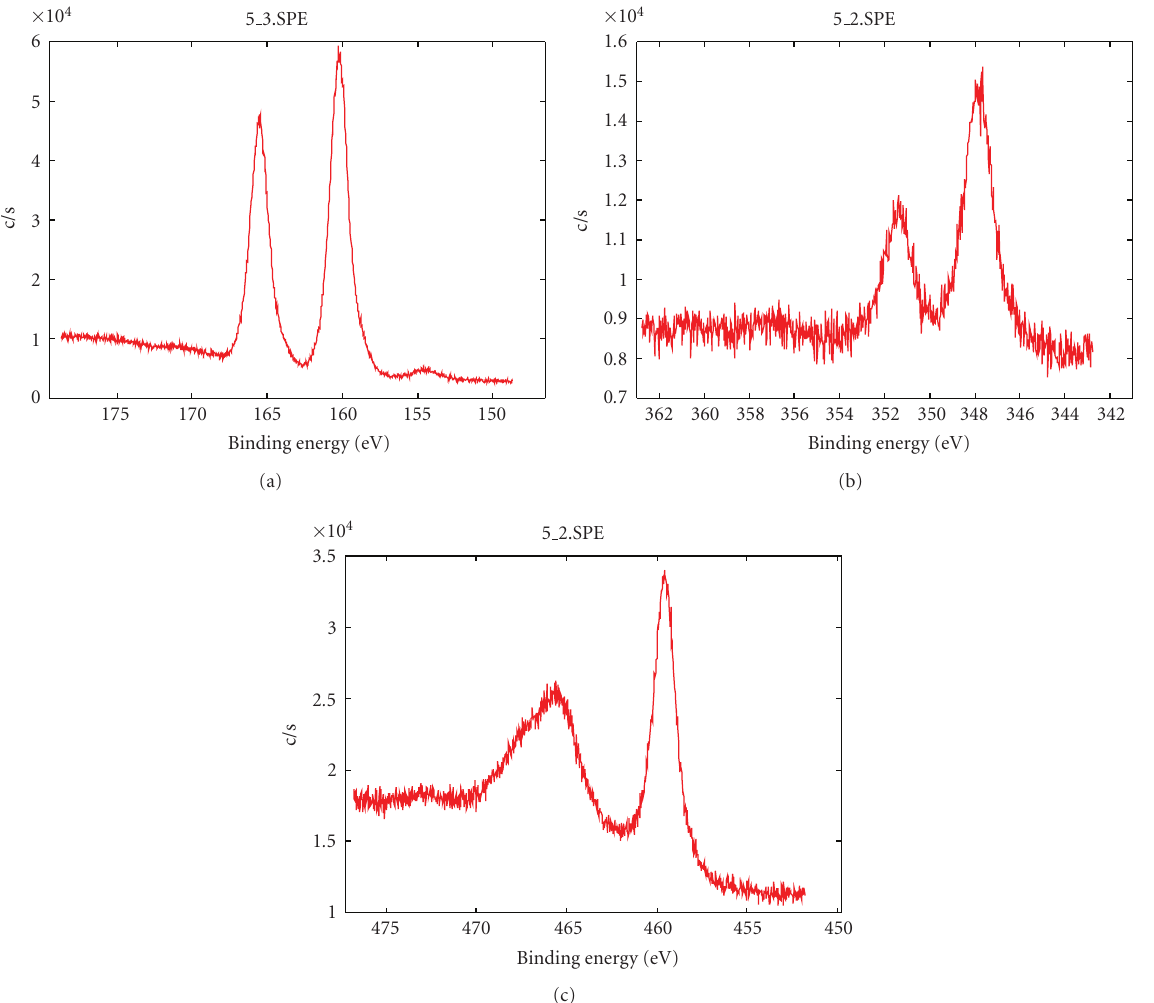
Figure 5: XPS spectra of (a) Bi 4f, (b) Ca 2p, (c) Ti 2p peaks for CBTi144 thin films deposited by the soft chemical method at 700 ◦ C for 2